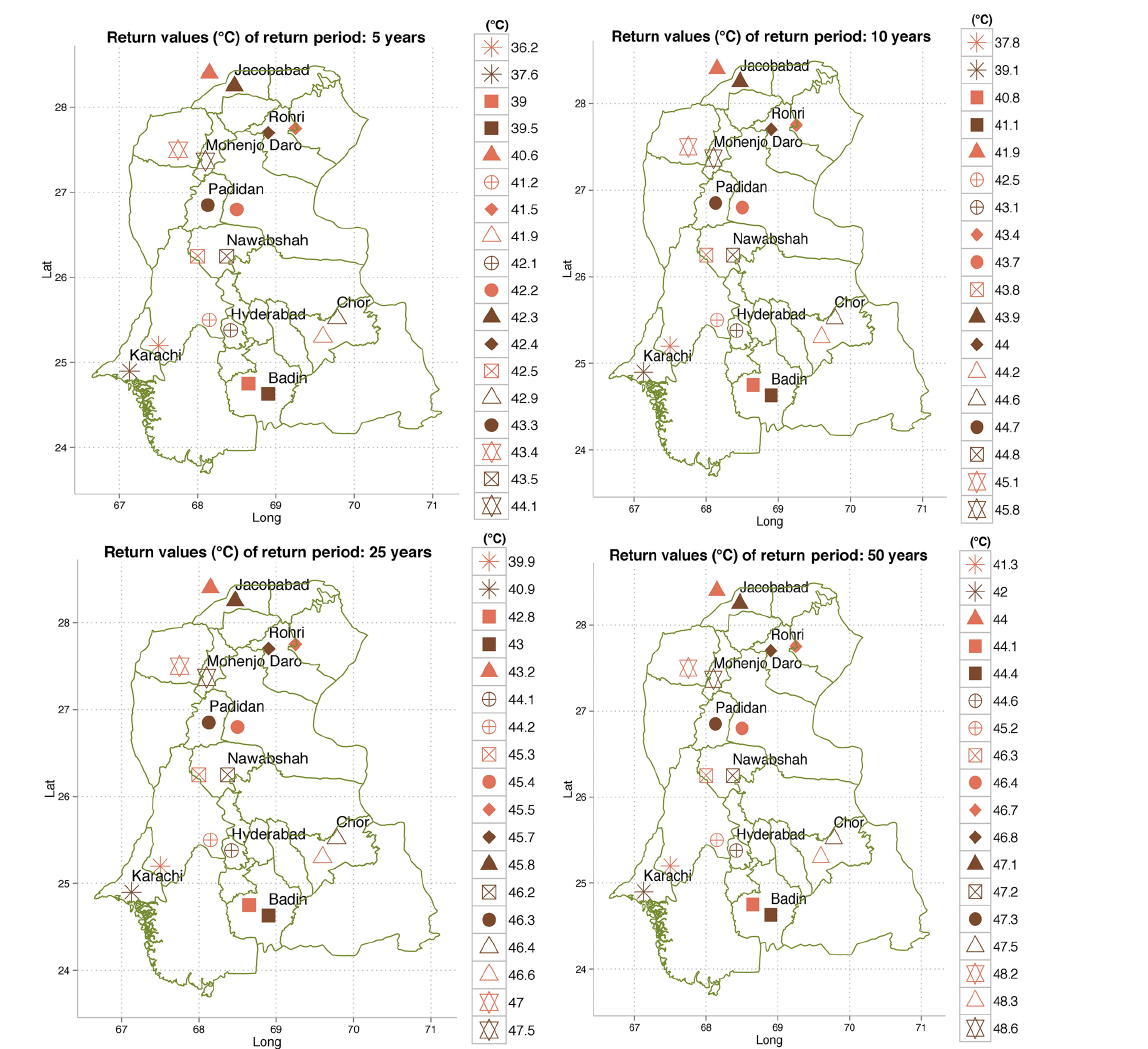
Figure 9. Spatial distribution of the station-observed TW max (brown) and bias-corrected ERA-Interim TW max (orange) return levels in degrees Celsius corresponding to return periods of 5, 10, 25, and 50 years in southern